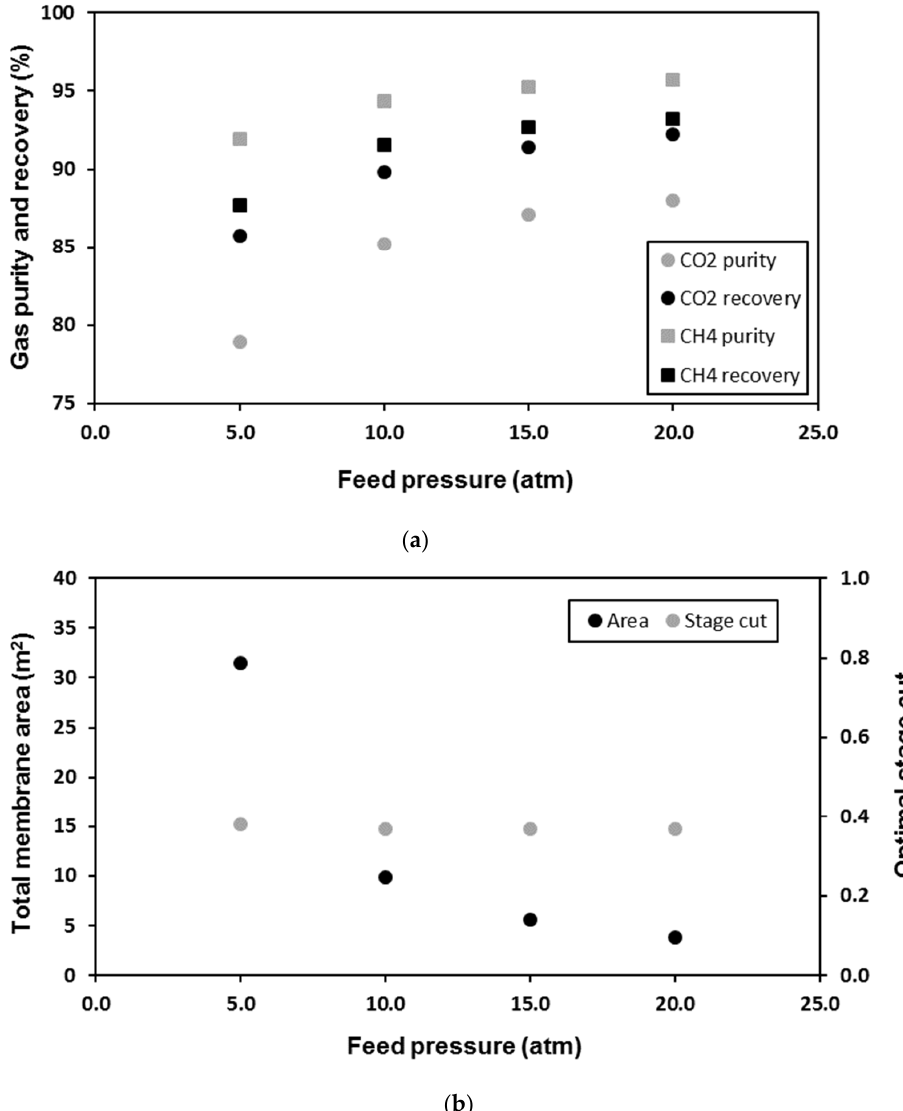
Figure 7. Influence of the maximal pressure value allowed in the feed side of the module on the optimal ( a ) recovery and purity and ( b ) stage cut and membrane area for the IL 2 membrane.